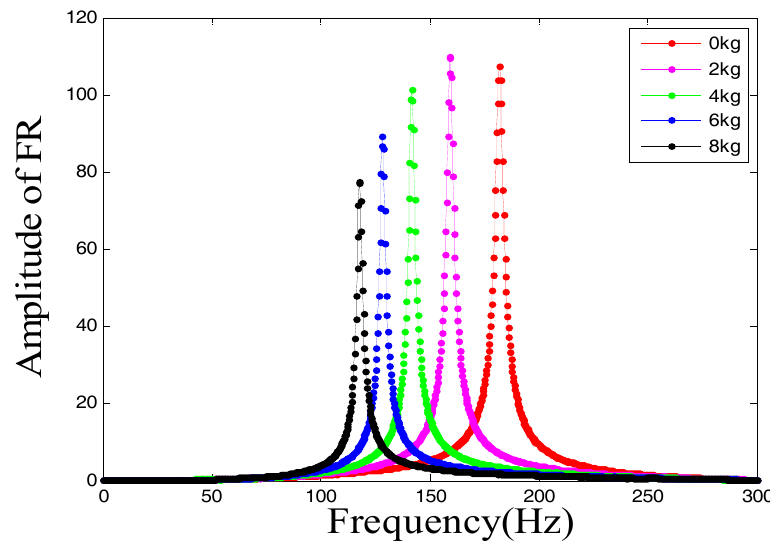
Figure 8. Changes of the first frequency with different masses (FEM). Appl. Sci. 2017 , 7 , 1040